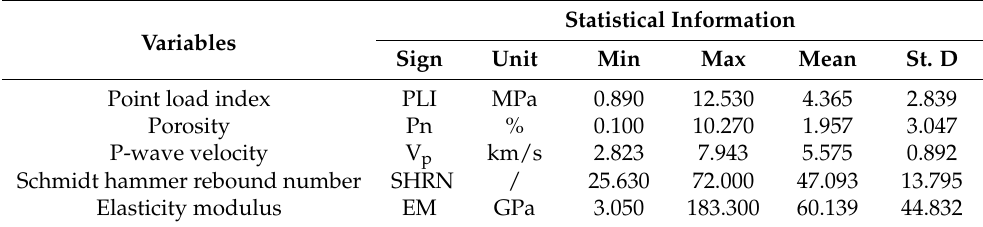
Table 1. Detailed description of the input and output